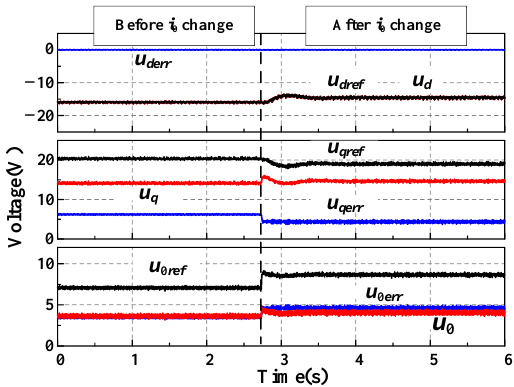
Therefore, the proposed method can improve the accuracy of parameter identification.